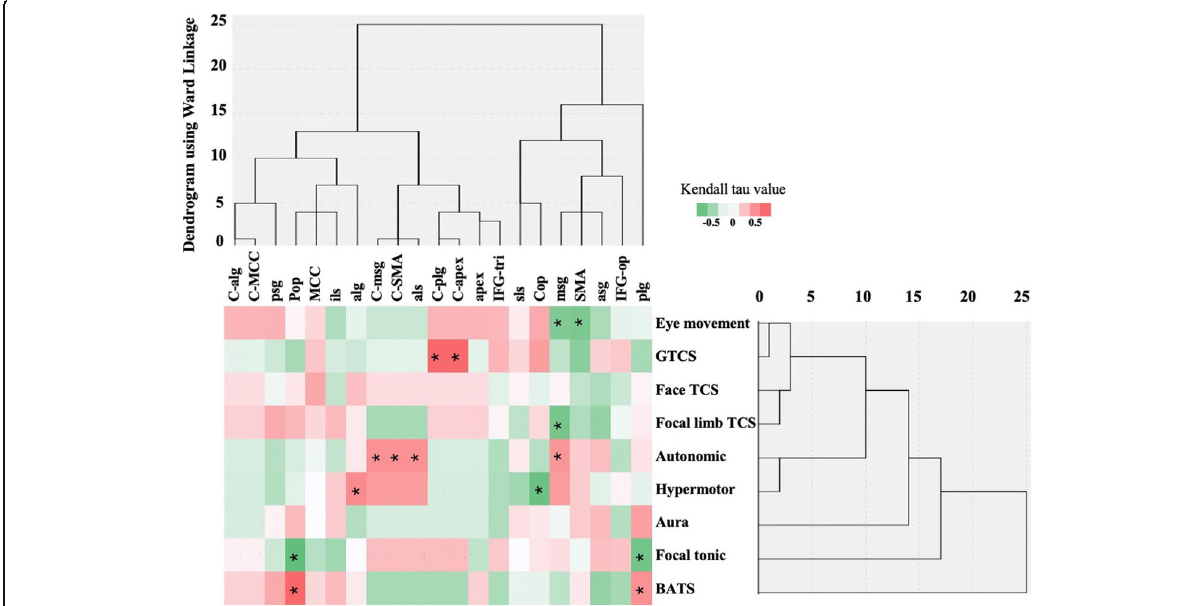
Fig. 2 Correlation matrix between clinical features and cortical structures. Upper: Clustering of cerebral cortical areas. Lower right: Clustering of clinical symptoms. Lower left: Correlation between structures and symptoms (green, negative correlation; red, positive correlation), which shows components of seizure semiology related to different early spread networks in varying degrees. * P <